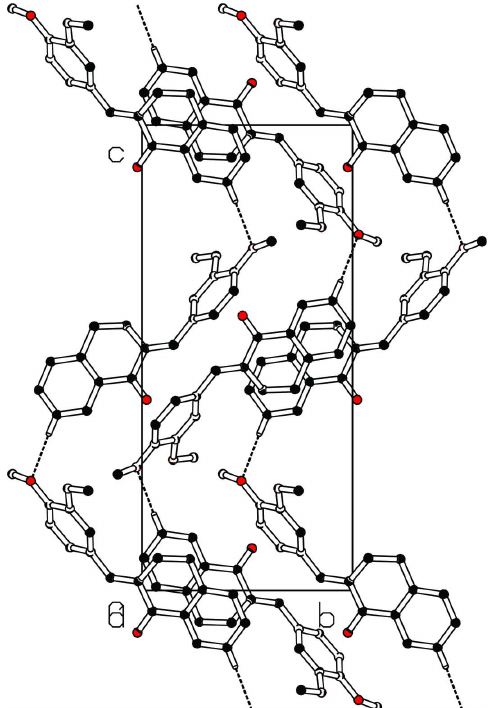
Figure 2 Packing of the molecules along the c axis with C—H (cid:3)(cid:3)(cid:3) O interactions running in a zigzag head-to-tail fashion, viewed along the a axis. The hydrogen bonds are shown as dashed lines. Hydrogen atoms not involved in hydrogen bonds are omitted for clarity.